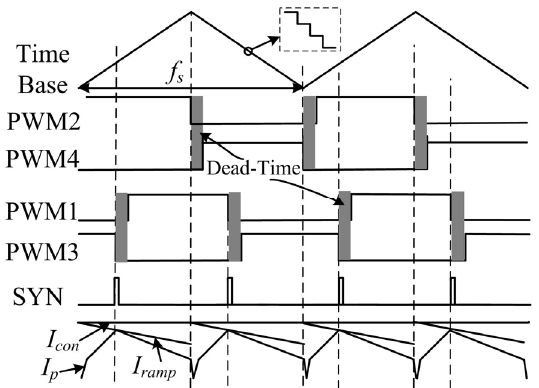
Figure 17. PWM signal generation with